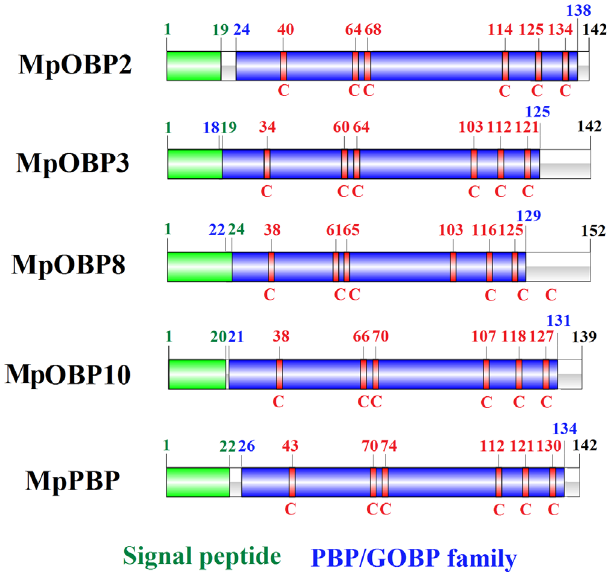
Figure 4. Sequence characteristics analysis of fi ve M. pallidipes odorant-binding proteins (OBPs). Green represents signal peptides, blue represents conserved sequences of the PBP/GOBP family, and red represents cysteine. Numbers indicate amino acid